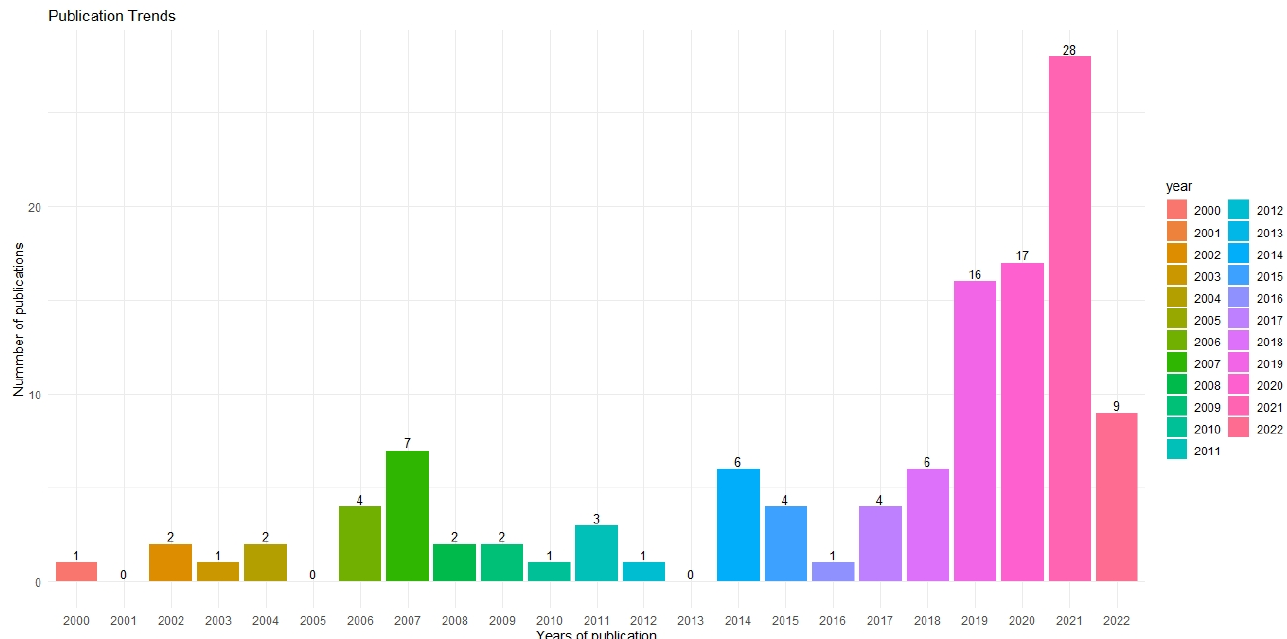
Figure 4. Publication trends in primary articles from 2000 to 2022.